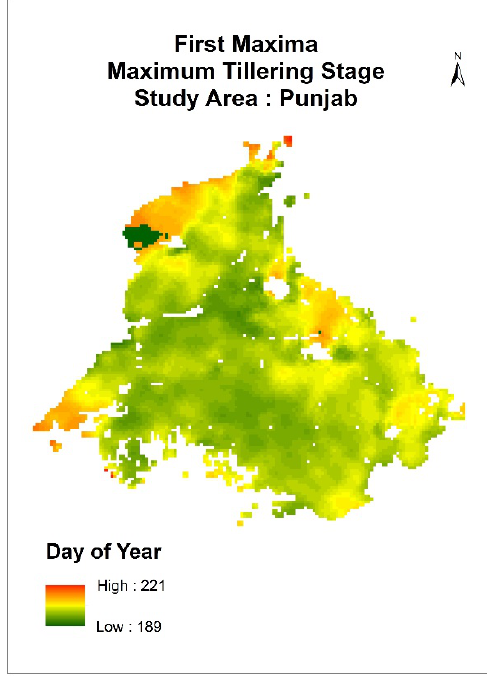
Figure 3: Maximum Tillering Stage of Rice for Punjab